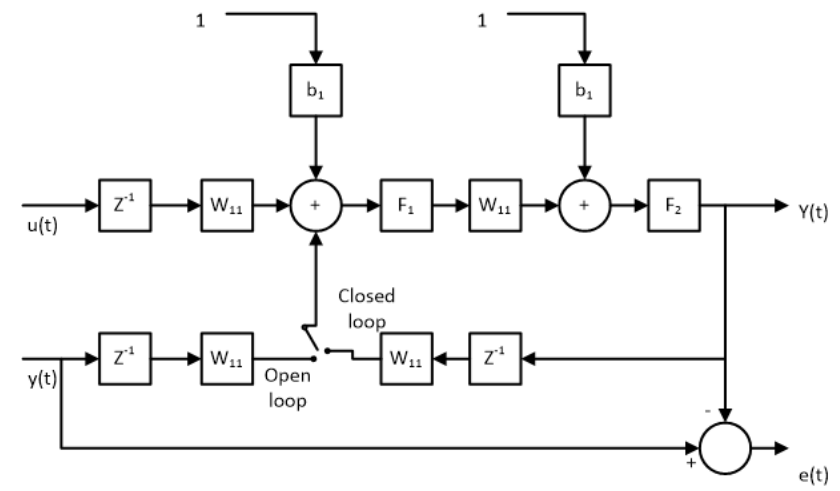
Figure 1. NARX artificial neural network